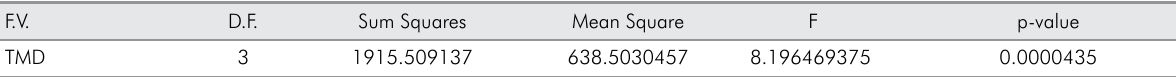
Table 4. Results of ANOVA of SAQ score and Fonseca classification. F.V.